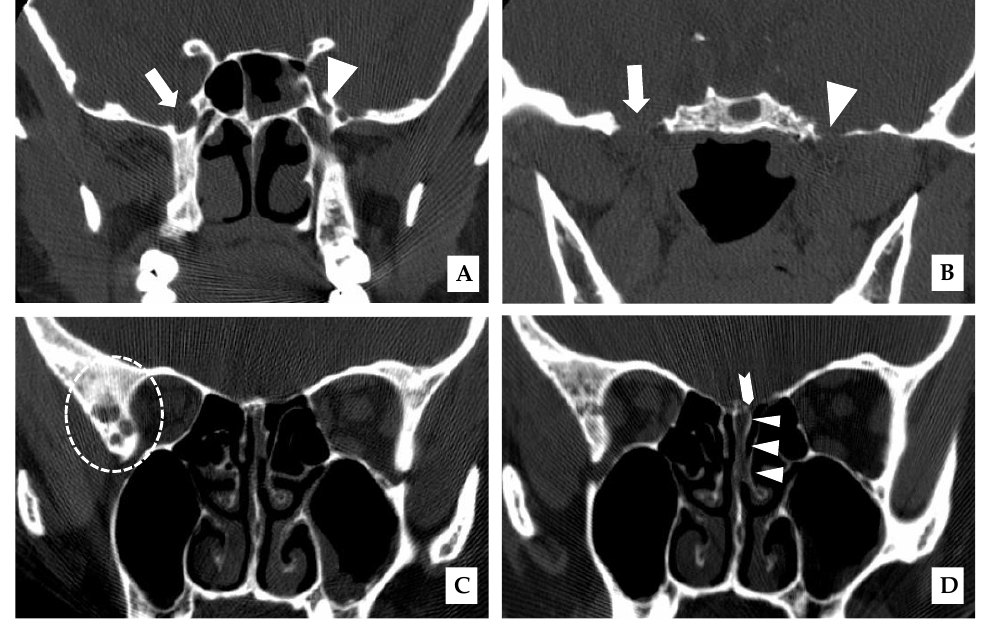
Figure 1. Coronal plane, unenhanced CT scan of the paranasal sinuses obtained with bone window and in prone position. ( A – D , Dec. 2007). ( A ): prominent right (arrow) and normal left (triangle) foramen rotundum; ( B ): prominent right (arrow) and normal left foramen ovale (triangle); ( C ): prominent right sphenoidal arachnoid pits (dashed circle); ( D ): focal defect of the left planum sphenoidale (chevron) and adjacent opacification of the left ethmoid sinus and upper nasal cavity (CSF leak, triangles).